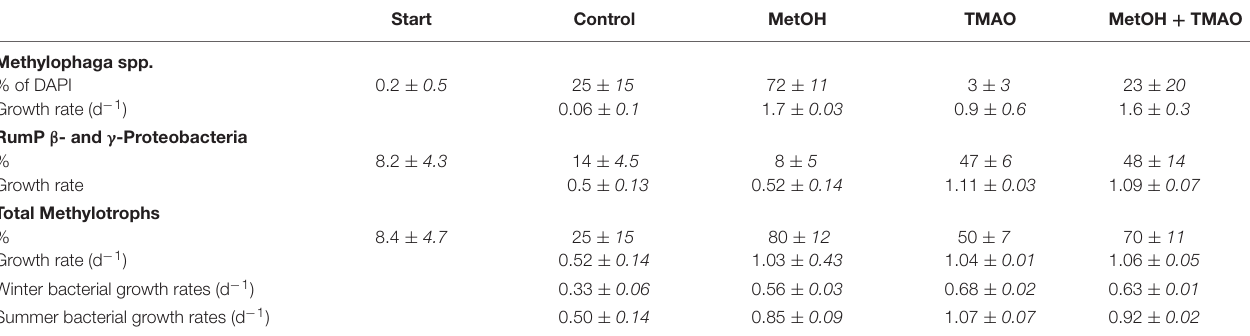
TABLE 3 | Winter contribution of methylotrophs (as a % of hybridized cells to DAPI cells at 120 h, standard deviation for n = 10 fields of view) to total bacterial abundance, and total bacterial growth rates during the active phase of the winter and summer experiments. Start Control MetOH TMAO MetOH +